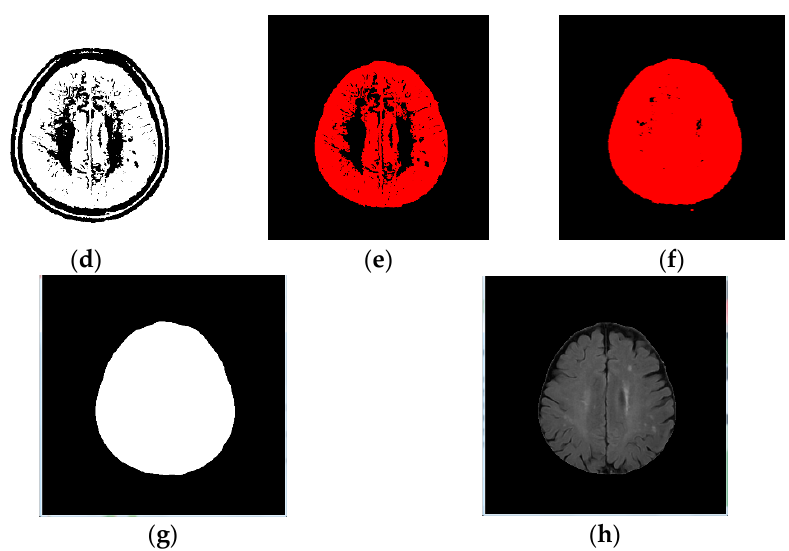
Figure 1. ( a ) Original brain image; ( b ) image binarization; ( c ) removed head shell; ( d ) image binarization (reverse); ( e ) removal of the head shell; ( f ) steps 2 and 4 added; ( g ) mask image; ( h ) result image (header).